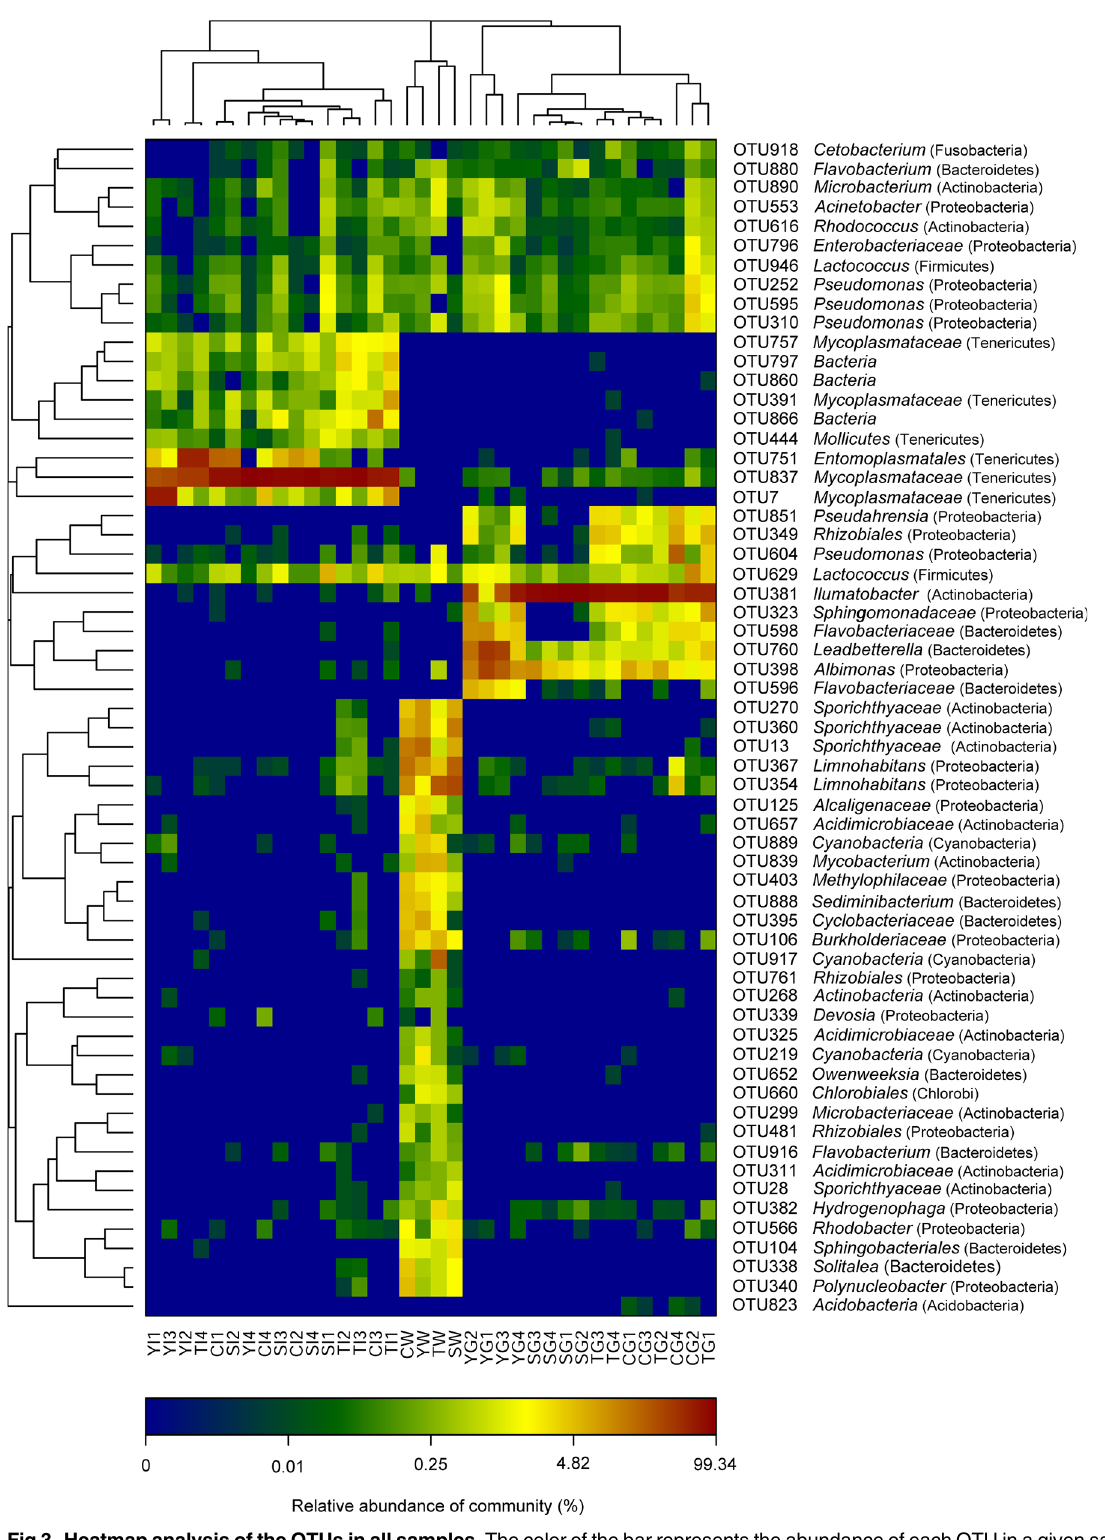
PLOS ONE | DOI:10.1371/journal.pone.0148135 January 28,